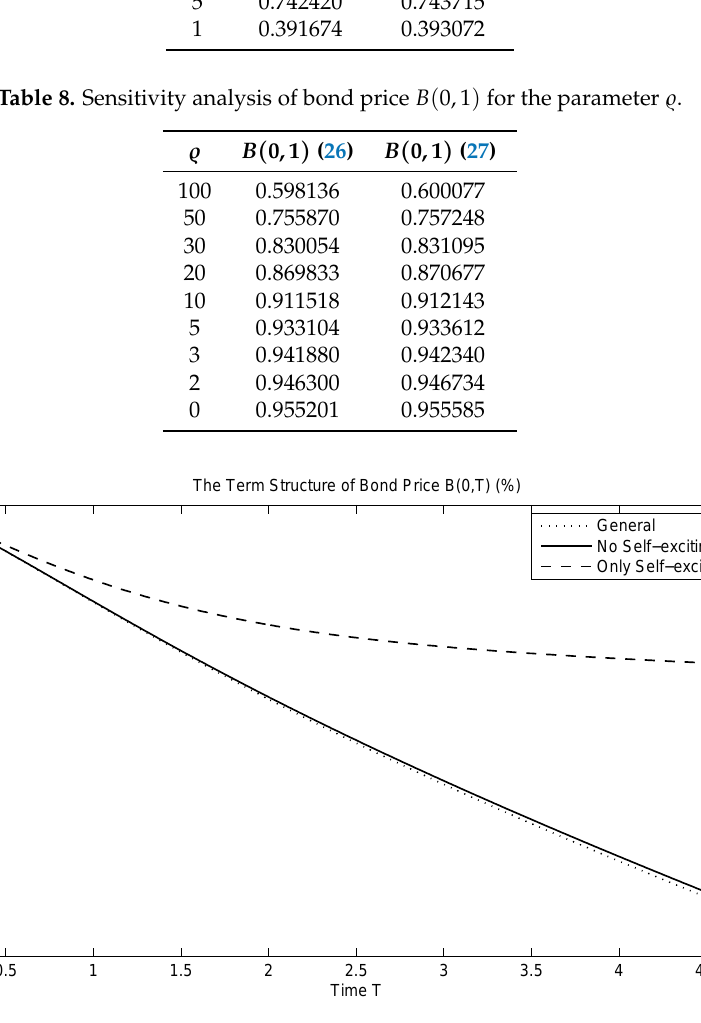
Figure 3. Term structure of bond price B ( 0, T )